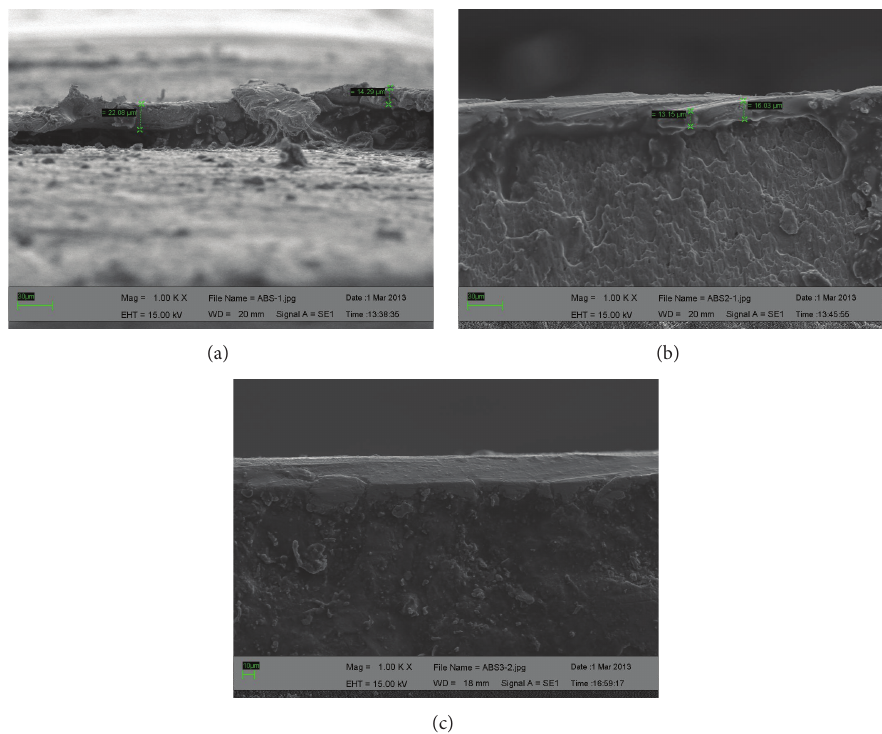
Figure 2: Coating thickness measurement by SEM: (a) ABS-1, (b) ABS-2, and (c) ABS-3.